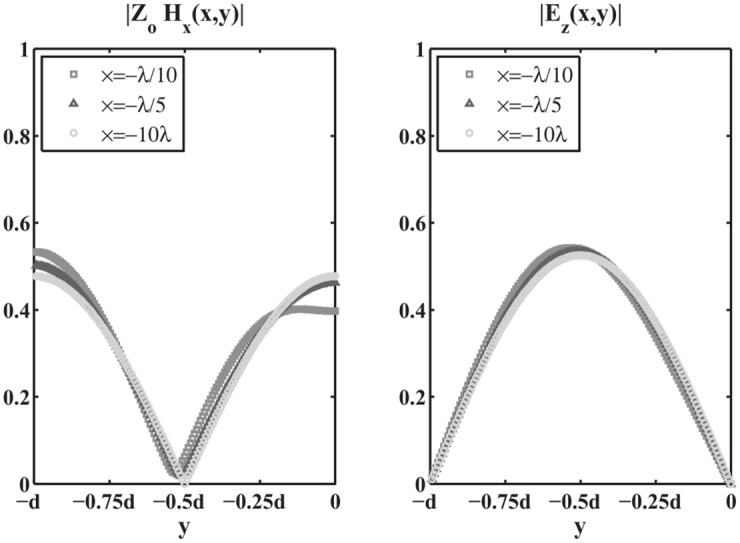
Modal field.Modal field ZoHx(x, y) and Ez(x, y) at x = [−λ/10, −λ/5, −10λ] with Ni = 100 for the test case of Fig 24 with parameters [Φa, φo, d] = [0.8π, 0.55π, 0.55λ].